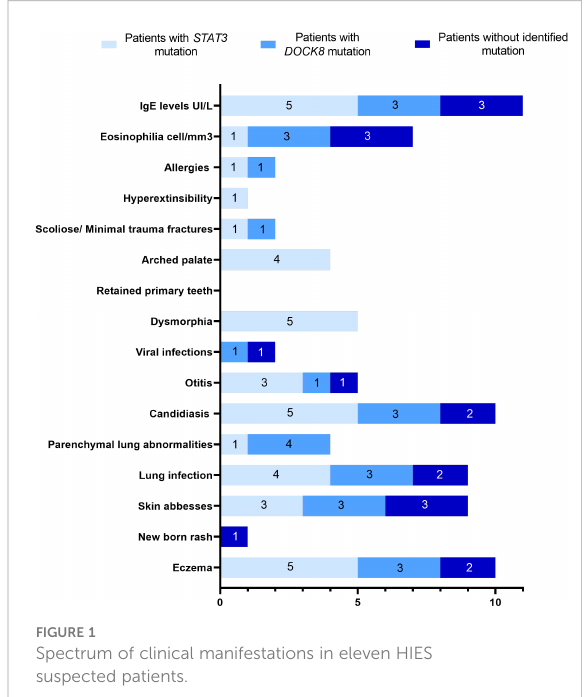
FIGURE 1 Spectrum of clinical manifestations in eleven HIES suspected